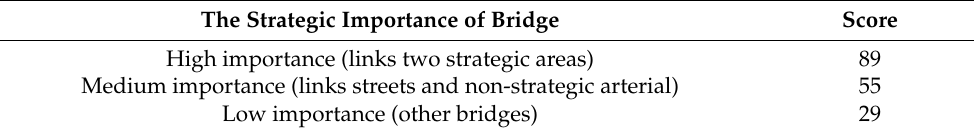
Table 15. Scores of the strategic importance